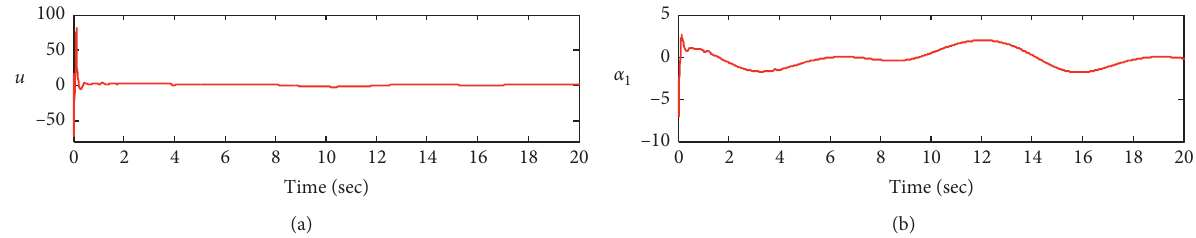
Figure 9: Profiles of control inputs u and α